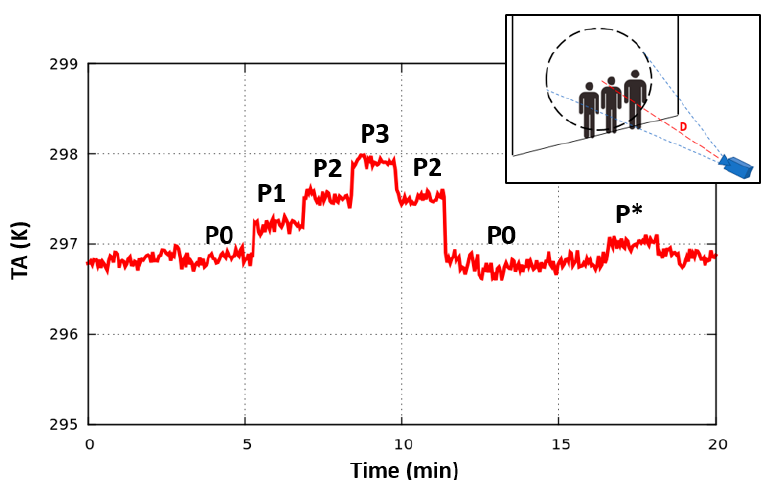
Figure 17. Antenna temperature T A measured by the radiometer for the stationary situation depicted in the right inset. Experiment settings: P0: persons are absent; P1: one person is inside the footprint; P2: two persons are inside; P3: three persons are inside; P*: one person is positioned at the edge of the antenna half-power beamwidth β ( β = 30 ◦ , D = 4